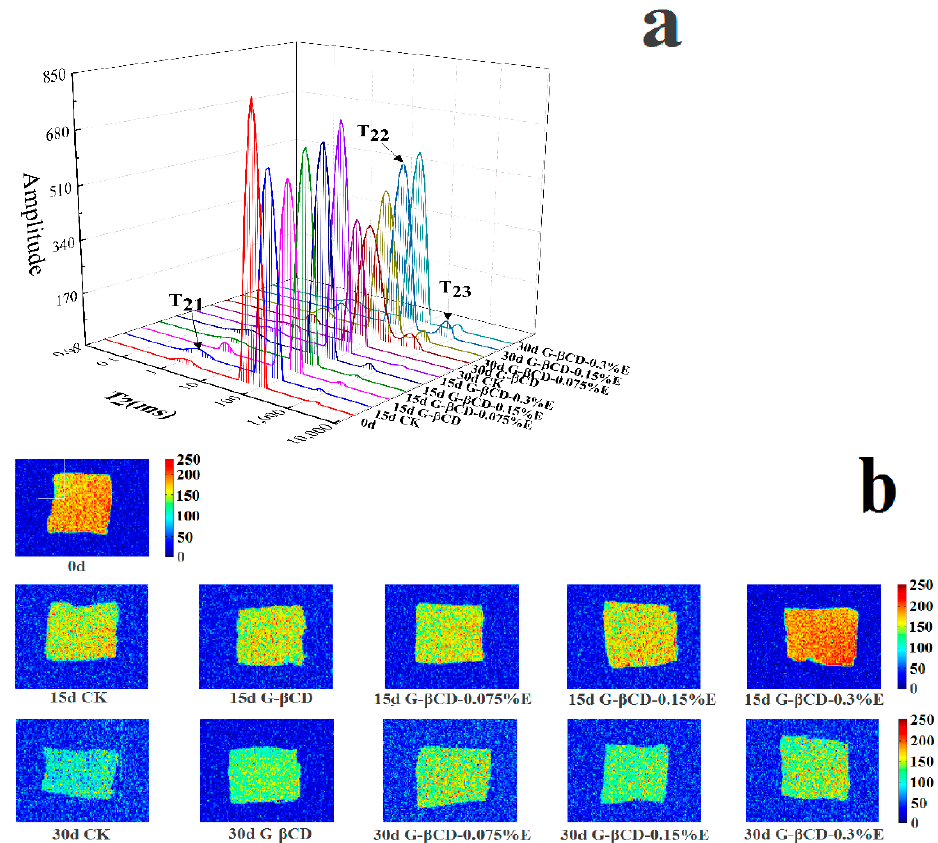
Figure 3. Changes in water distribution ( a ) and magnetic resonance imaging ( b ) of Chinese seabass during superchilling storage at − 0.9 °C. (CK: uncoated; G- β CD: gelatin- β -cyclodextrin coating without eugenol; G- β CD-0.075%E: gelatin- β -cyclodextrin coating with 0.075% eugenol; G- β CD-0.15%E: gelatin- β -cyclodextrin coating with 0.15% eugenol; G- β CD-0.3%E: gelatin- β -cyclodextrin coating with 0.3% eugenol).